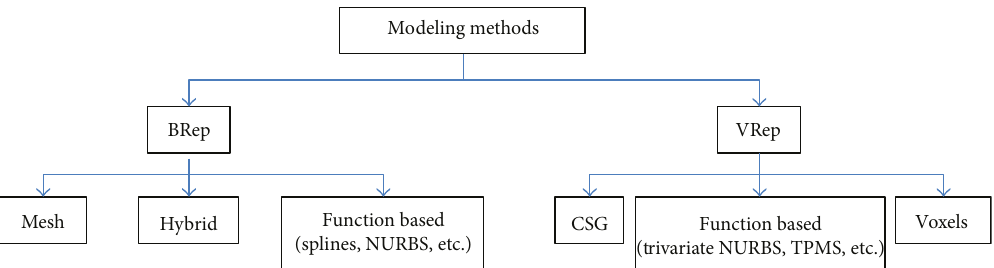
Figure 7: Cellular material modeling